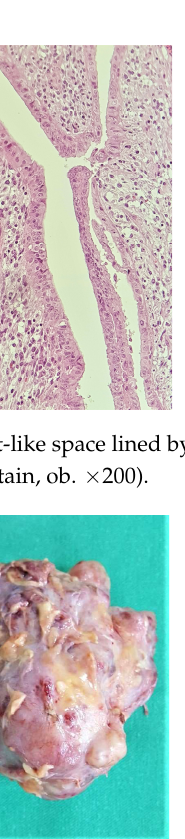
Figure 3. Macroscopic aspect of the right breast tumor.